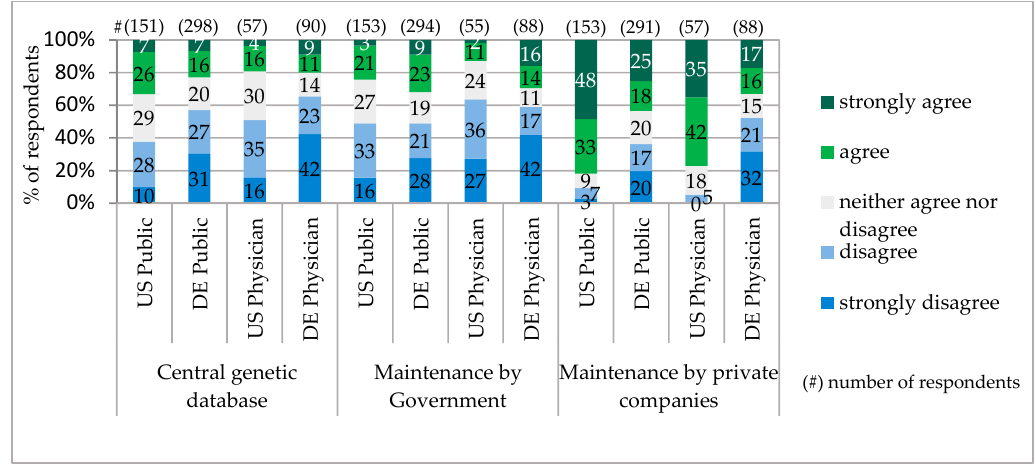
Figure 4. Concern about Genetic Data Security.